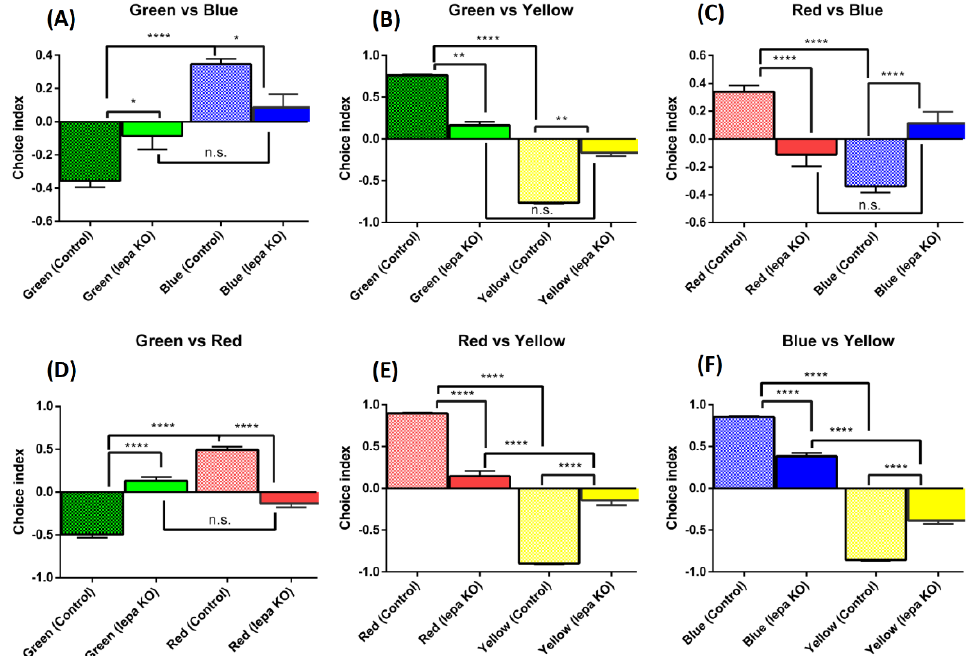
Figure 6. Comparison of color preferences between wild type and lepa KO zebrafish: ( A ) green vs. blue combination; ( B ) green vs. yellow combination; ( C ) red vs. blue combination; ( D ) green vs. red combination; ( E ) red vs. yellow combination; and ( F ) blue vs. yellow combination. Data were analyzed using two-way ANOVA followed by Tukey post-hoc test. If the data were not normally distributed, they were analyzed using non-parametric Kruskal–Wallis followed by Dunn’s post-hoc test, and p < 0.05 was considered significantly different. The data are presented with mean ± SEM with n = 24, * p < 0.05, ** p < 0.01, *** p < 0.001, **** p > 0.0001.